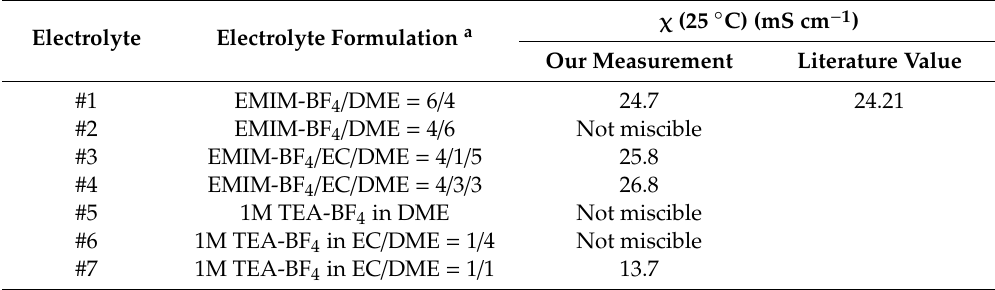
Table 11. The conductivity of electrolyte formulations designed in this study. Electrolyte Electrolyte Formulation